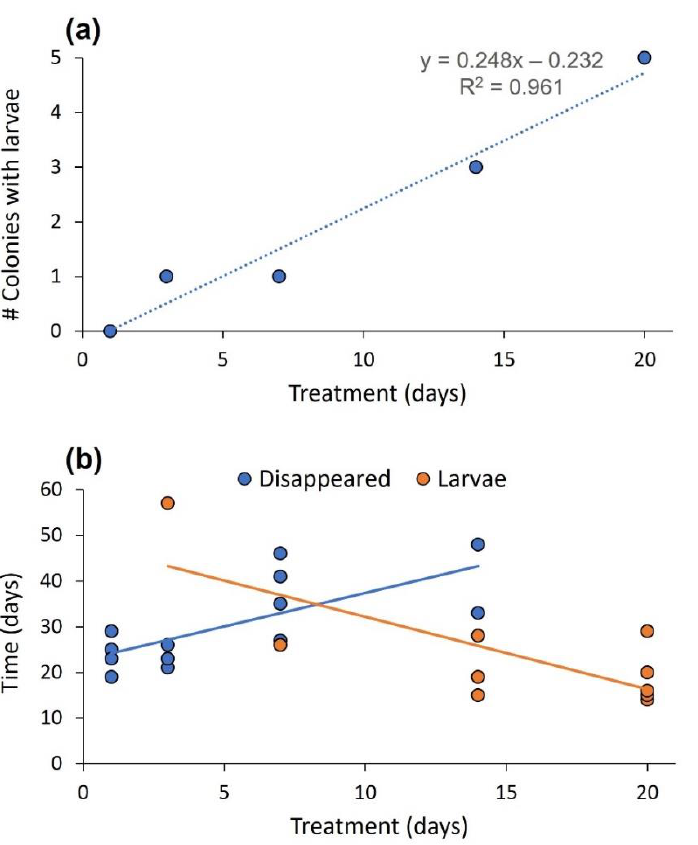
Figure 3. Experiment 2. ( a ) The number of colonies that finished the experiment with larvae (y axis) vs. the treatment, or the number of days spent at the higher temperature after the first appearance of eggs (x axis). The longer the eggs experienced the higher temperature, the higher their probability was to develop into larvae. ( b ) The interactive effect of the treatment and the egg fate, i.e., to become larvae or disappear, on the time elapsed until reaching one of the two situations.